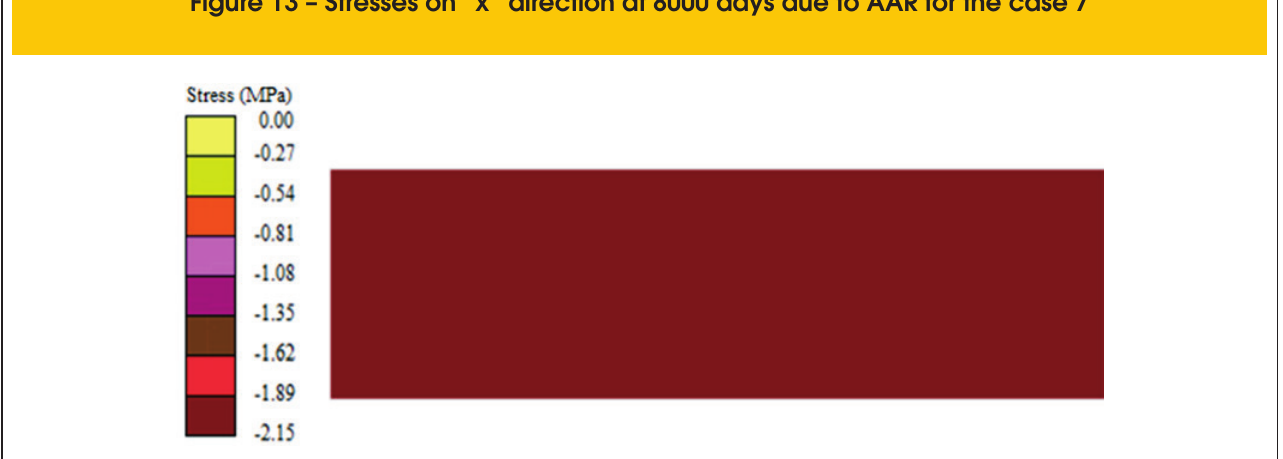
Figure 13 – Stresses on “x” direction at 8000 days due to AAR for the case